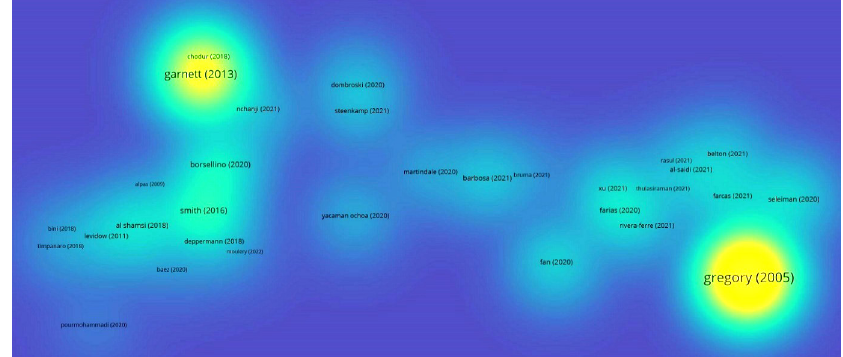
Figure 3. Density map of bibliographic coupling of research in the food security and short supply chain area, 1990–2022